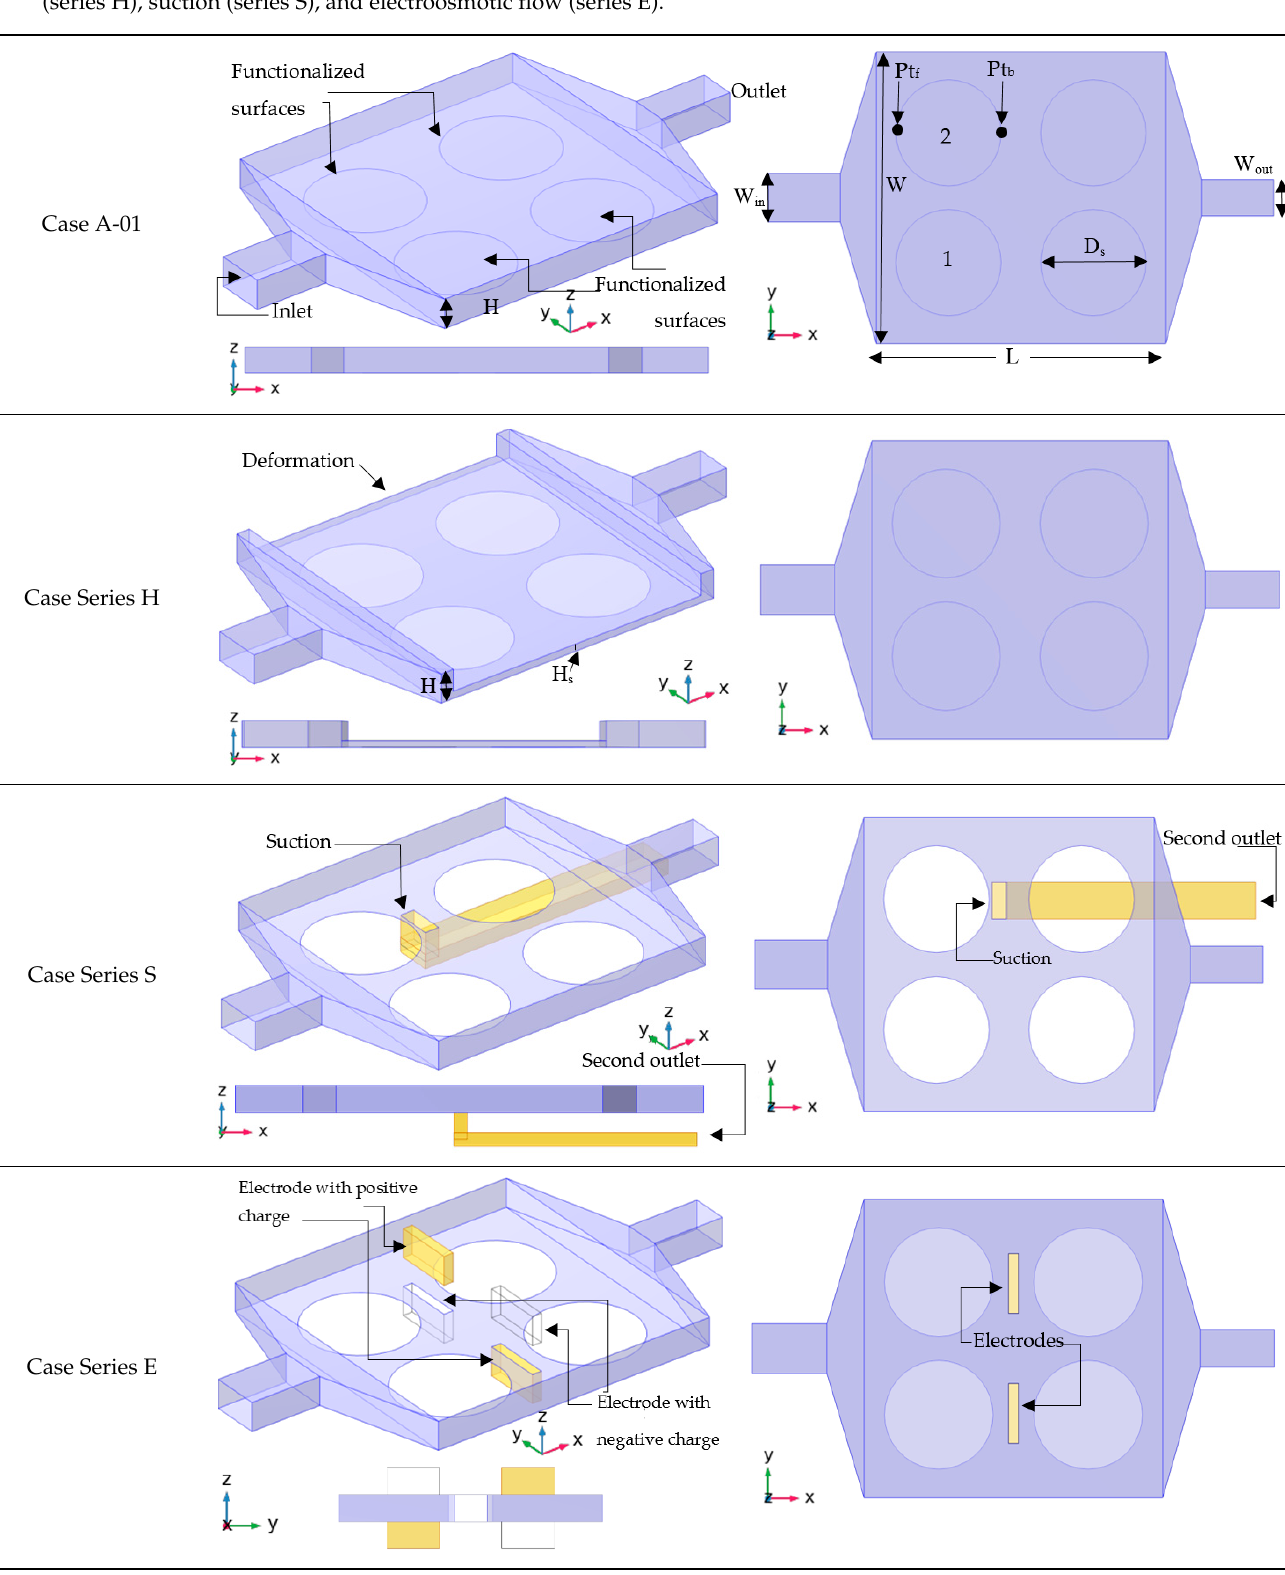
Table 2. The geometry of the microchamber for four types of setups; original experimental setup (Case A), thin chamber (series H), suction (series S), and electroosmotic flow (series E).